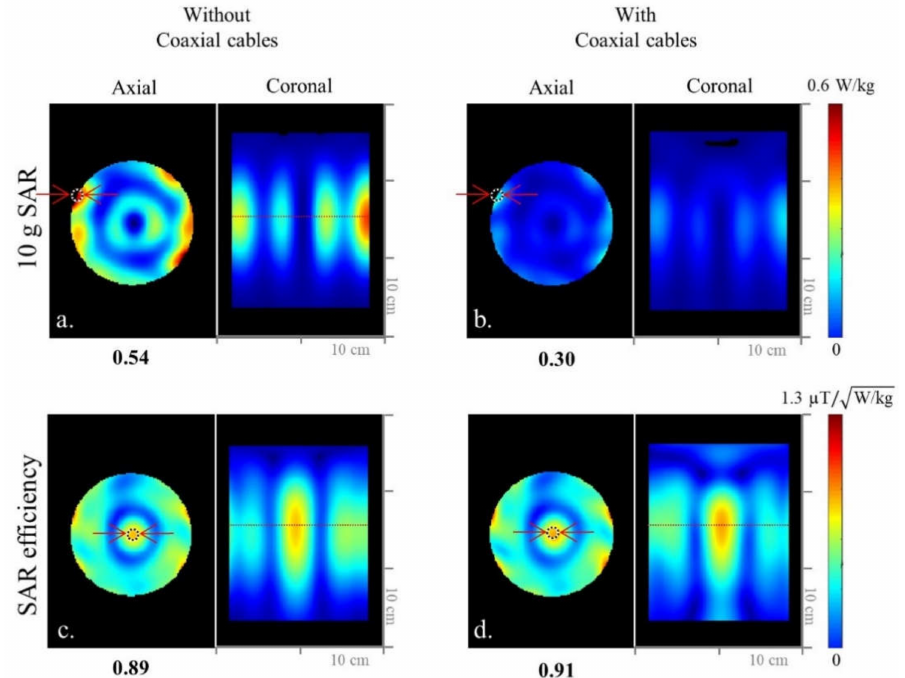
Figure 2. Simulated 10 g SAR ( a , b ) and SAR efficiency ( c , d ) maps of the 8-channel inductor-shortened dipole antenna array without and with coaxial cable setups in the axial and coronal